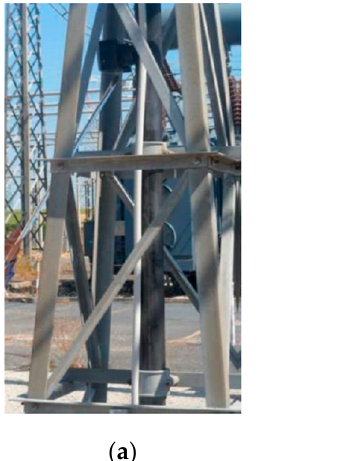
5 of 16 Figure 4. The wireless remote RF synchronizer apparatus. As shown in Figure 4, the remote synchronizer has many sensing features such as magnetic and electric field sensors, a light sensor, and a connector to an arbitrary external source. The Pry-Cam TM Portable can be adopted for PD detection in HV/MV electric components such as cables, joints, terminations, and electrical machines like transformers and rotating machines [7,17]. The behavior of the Pry-Cam TM sensor enables the user to successfully detect the waveform of a typical PD repeated transient radiated electromagnetic field, preserving the information necessary for the subsequent pattern analysis typically carried out by using conducted measure results, and more recently, by radio frequency analysis. The compactness of the probe and its characteristics made it possible to build a portable, low-cost device for PD detection useful for non-conducted measurements, without any interference with the normal service of the apparatus under testing. Moreover, the behavior of the antenna sensor frequency response enables the user to precisely